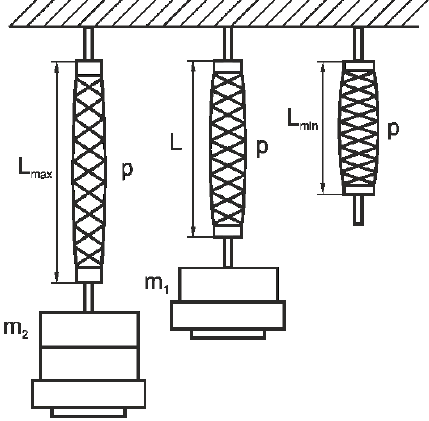
Fig. 5. The principle of determining the isobaric characteristics of the pneumatic artificial muscle.